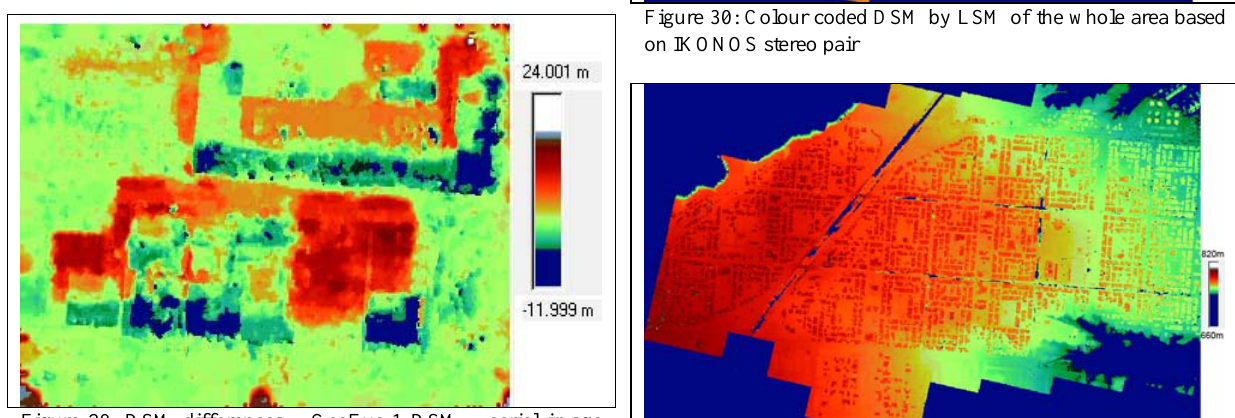
Figure 28: DSM differences – GeoEye-1 DSM minus IKONOS DSM based on SGM